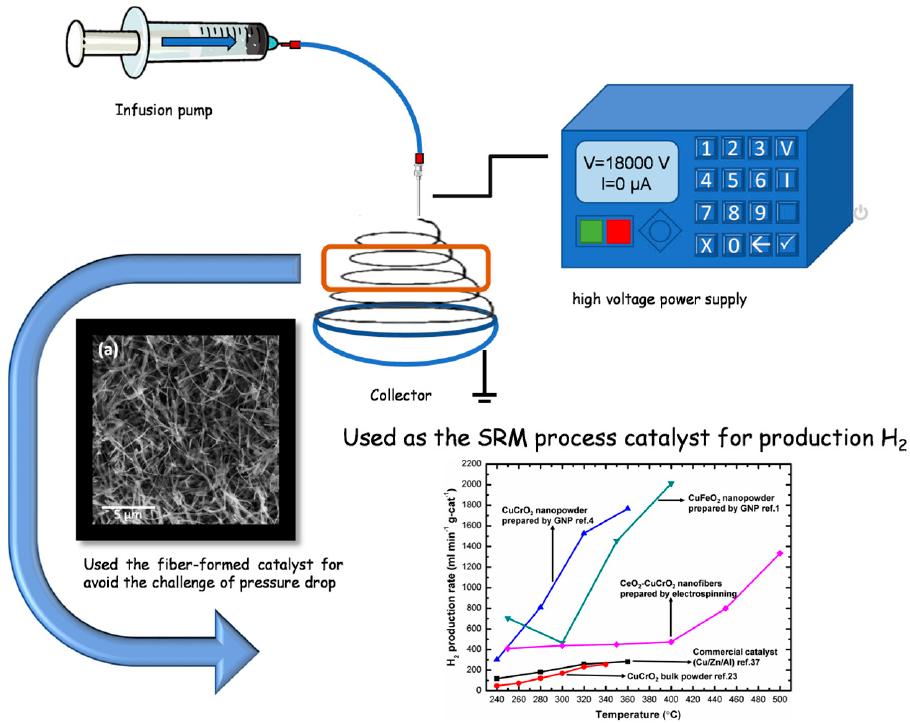
Figure 1. Schematic diagram of the methanol steam reforming process on the electrospun CeO 2 - CuCrO 2 nanofibers catalyst.